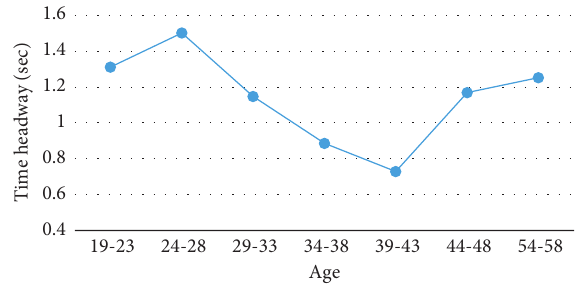
Figure 5: Relationship between TH and age of drivers in steady- state CF.